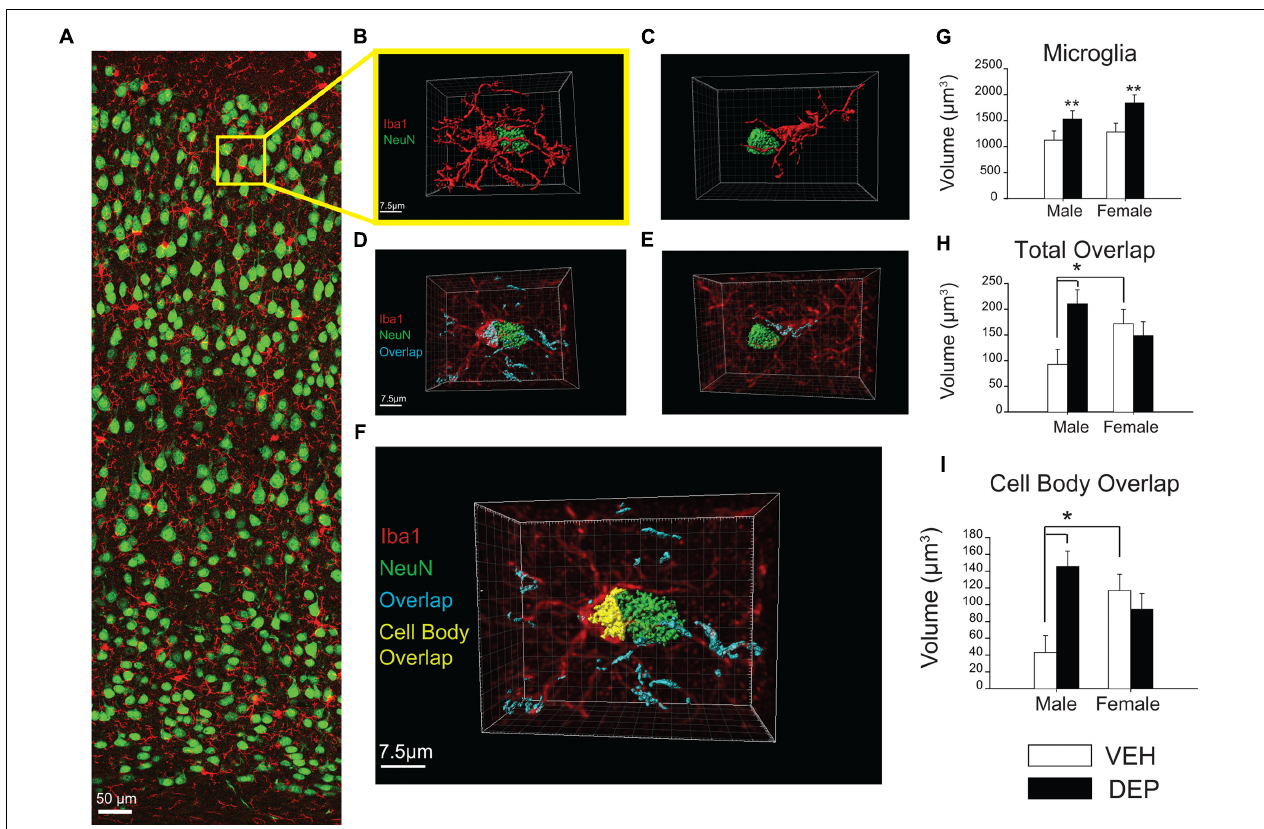
FIGURE 4 | Increased overlap between microglia and neurons in juvenile offspring prenatally exposed to DEP. (A) Representative panoramic image of microglia (Iba1, red) and neurons (NeuN, green) in the parietal cortex of a P30 DEP-exposed female taken at 40 × magnification and stitched together with 30% overlap. (B) Example 3D surface rendering of microglia-neuron apposition, imaged by confocal microscopy at 100 × magnification and reconstructed following a previously published protocol (Schafer et al., 2012, 2014). Neurons and microglia not involved in the microglia-neuron interaction were removed for clarity. (C) Example of microglia-neuron apposition that was excluded from analysis post-reconstruction due to lack of direct cell body contact. (D,E) 3D surface renderings of neurons (NeuN, green) and microglia-neuron overlapping regions (cyan). In these images, 3D reconstructed microglia appear in translucent red to allow visualization of overlapping material within microglia. Note: neurons not directly contacting the microglial cell body were removed for clarity but overlapping regions between microglial processes and these extraneous neurons were quantified as part of total overlap between microglia and neurons. (F) 3D reconstruction of microglia-neuron apposition including total overlapping material (cyan) and cell-body overlap (yellow). (G) Quantification of microglial cell volume. Analysis of reconstructed microglial volume revealed DEP-exposed offspring have larger microglia volumes than those exposed to VEH. (H) Quantification of total microglia-neuron overlap. Total overlap includes overlapping material between microglial processes and any surroundings neurons, as well as cell body-cell body overlap. Analysis of the total volume of Iba1-NeuN overlap revealed a significant Sex X DEP interaction, which is driven by a larger overlap volume in DEP males vs. VEH males, as well as a larger overlap volume in VEH females vs. VEH males. (I) Quantification of cell body overlap. Cell body overlap is restricted to overlap between one microglia and one neuron, and just between the cell bodies of these two cells. Analysis of cell body overlap revealed a significant Sex X DEP interaction, which we determined to be due to a larger volume of cell body overlap in DEP males vs. VEH males, as well as in VEH females vs. VEH males. Bar graphs represent mean values ± SEM (error bars); n = 3 mice/group, 3–5 microglia-neuron renderings per mouse. The data were log-transformed for analysis due to unequal variance, but are displayed as raw data in the figures. Grid line increments = 2.5 µ m. ## p < 0.05, males vs. females; ∗∗ p < 0.05, DEP vs. VEH; ∗ p < 0.05, vs. VEH